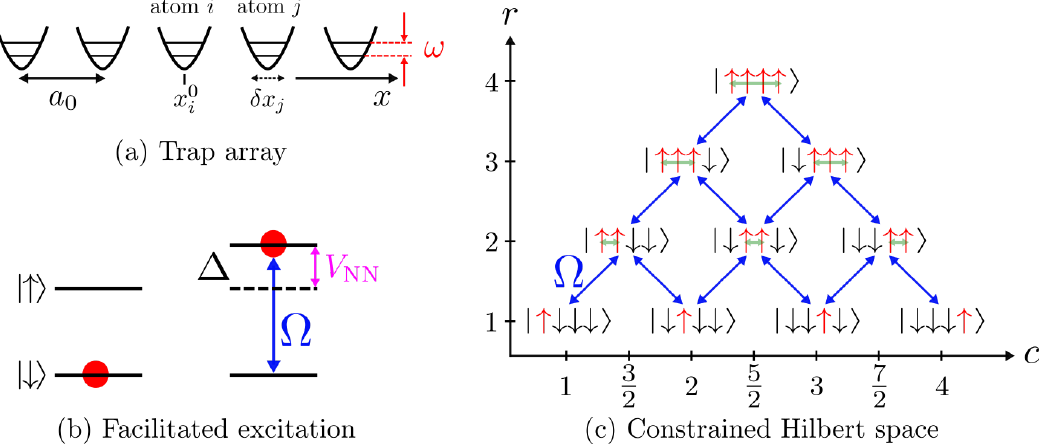
Figure 1: Setting and structure of constrained Hilbert space : (a) The system we consider consists of a one-dimensional lattice of N harmonic traps with harmonic frequency ω . The chain is orientated in x -direction and the spacing between adjacent traps is a . Each of the traps contains a single atom. The position of the center of 0 the trap containing the i -th atom is denoted with x 0 , while the displacement of the i atom position from the respective trap center is δ x . (b) Each atom is modeled as i a two-level system, in which the states |↓〉 and |↑〉 represent the ground state and the (Rydberg) excited state, respectively. The atoms are excited with a laser with Rabi frequency Ω and detuning ∆ . The facilitation constraint is established when ∆ + V = 0, where V denotes the interaction between two adjacent atoms in their NN NN respective equilibrium positions. (c) For Ω (cid:28) ∆ , a kinetically constrained dynamics is implemented, which takes place between resonant states. The constraint manifests in a reduced connectivity between states in the Hilbert space: starting from an initial single excitation, clusters of adjacent Rydberg excitations are formed. Such states are described in terms of two coordinates, c and r , labeling the position of the center of mass and the number of excitations, respectively. Clusters containing at least two Rydberg excitations feature mechanical forces that act on the atoms on the edges of the excitation clusters (indicated by green